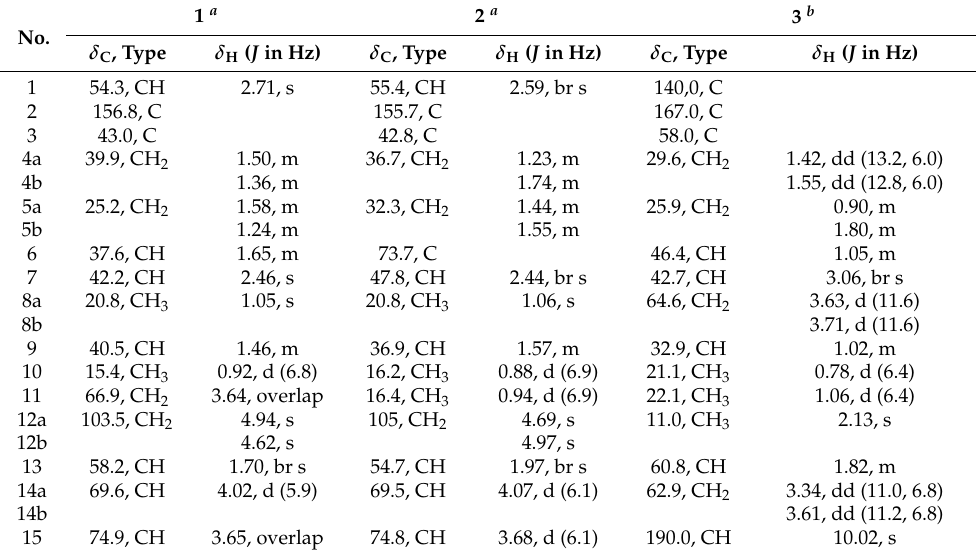
a Measured in CDCl b Measured in methanol- d 3 ; 4 . Bipolarisorokin B ( 2 ): colorless oil; [ α ] 22 D − 100.1 ( c 0.05, MeOH); UV (MeOH) λ